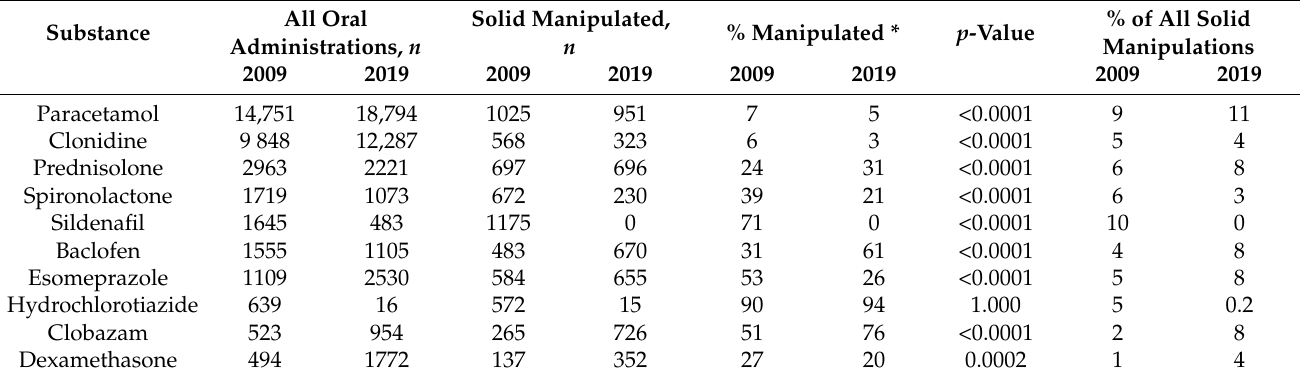
Table 2. Substances contributing to more than 50% of all solid oral manipulated medicines in 2009 and 2019 for inpatients.